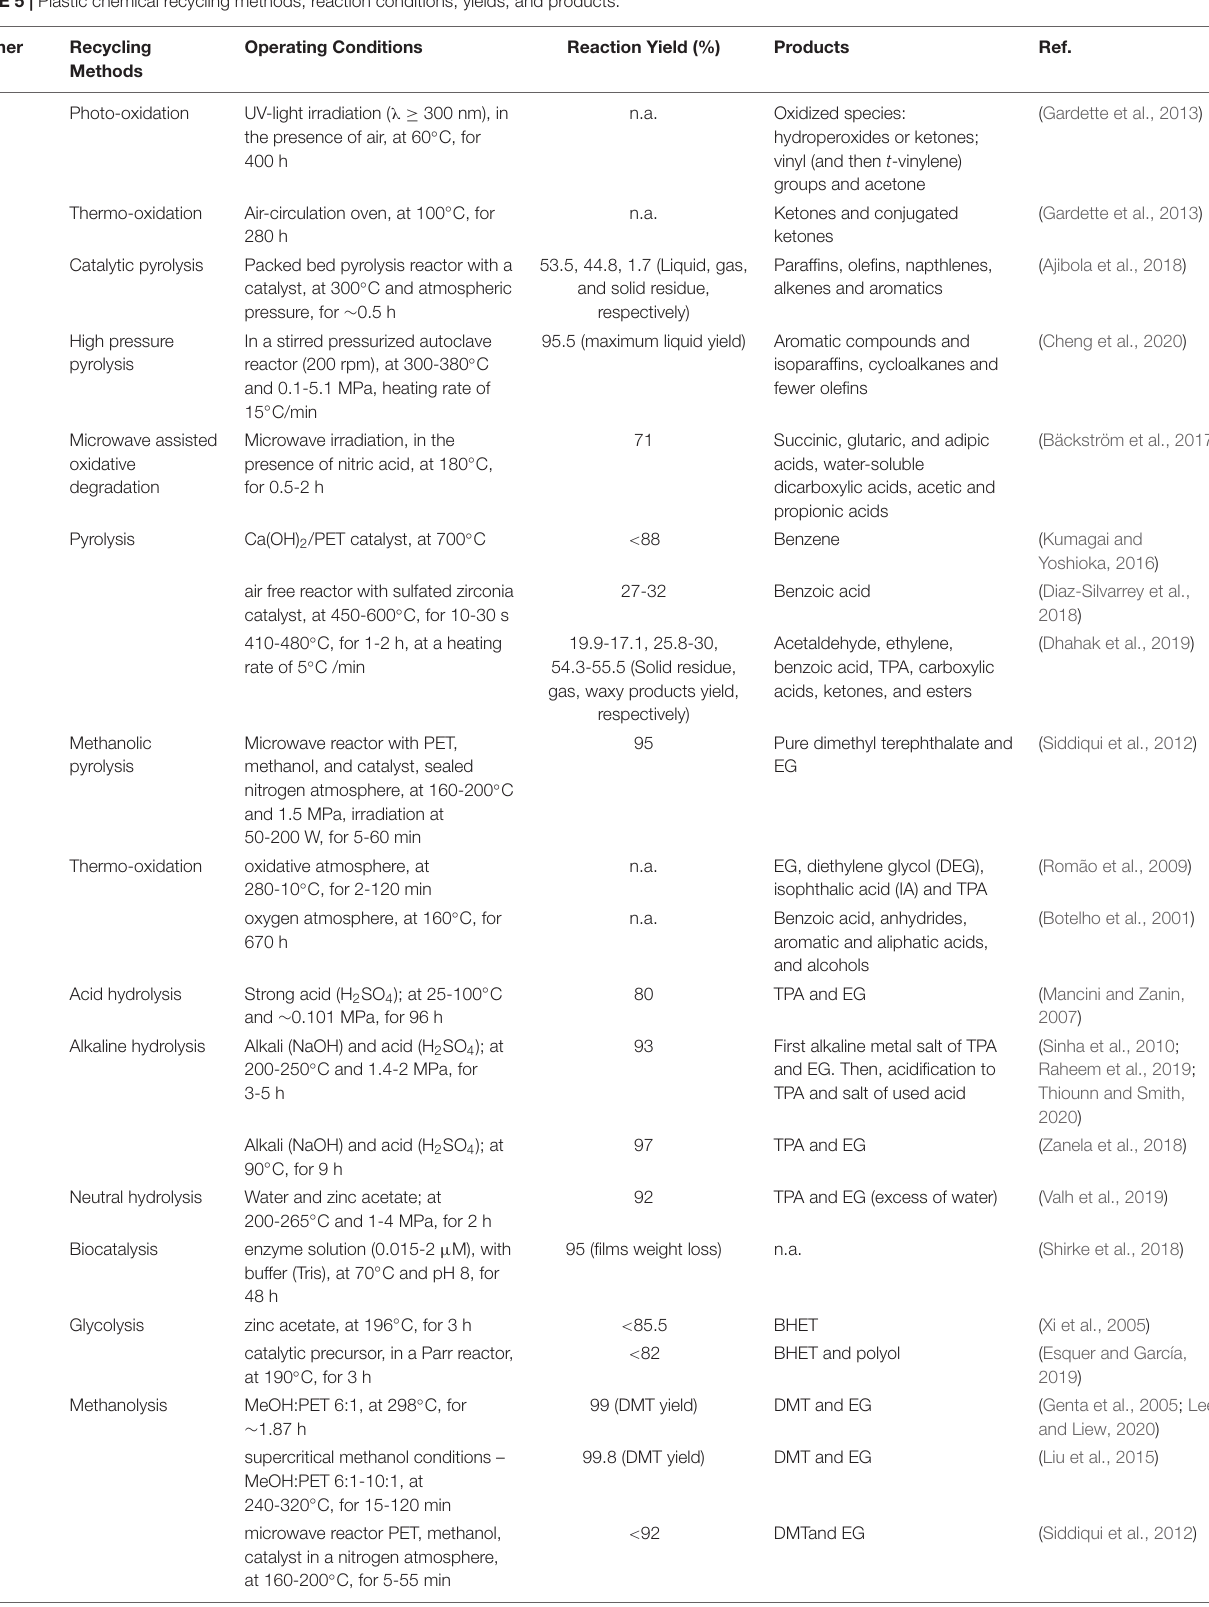
TABLE 5 | Plastic chemical recycling methods, reaction conditions, yields, and products.